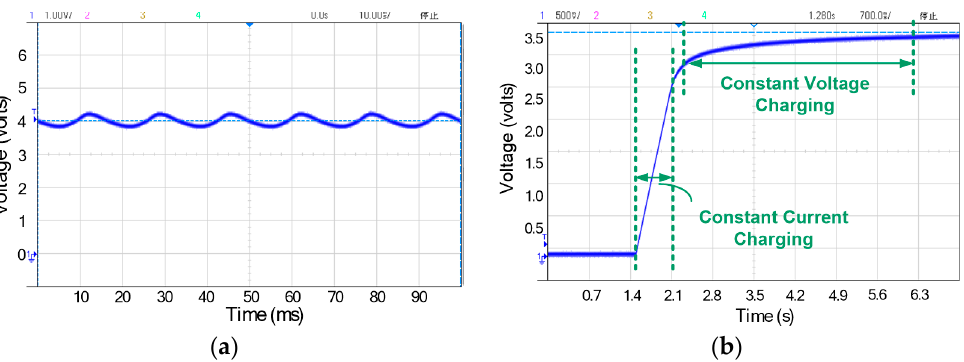
Figure 14. Measurement results of the power management unit: ( a ) Measured output waveform of the RF-DC converter; ( b ) Measured waveform of charging progress by the on-chip charger.